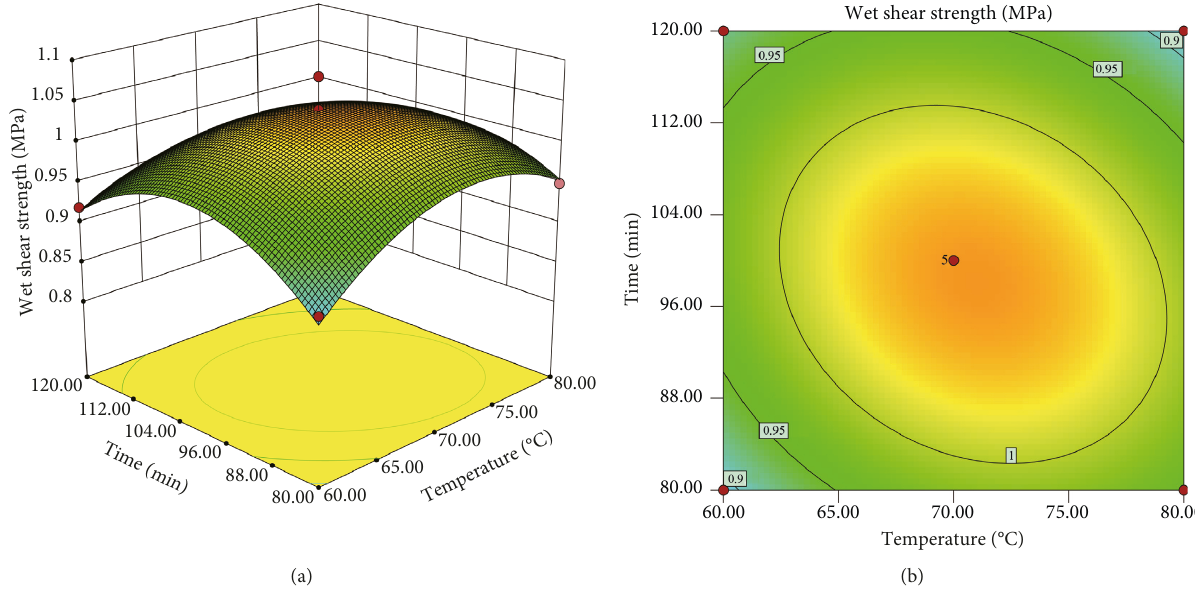
Figure 7: Response surface and contour plots for effect of time and temperature on wet shear strength.